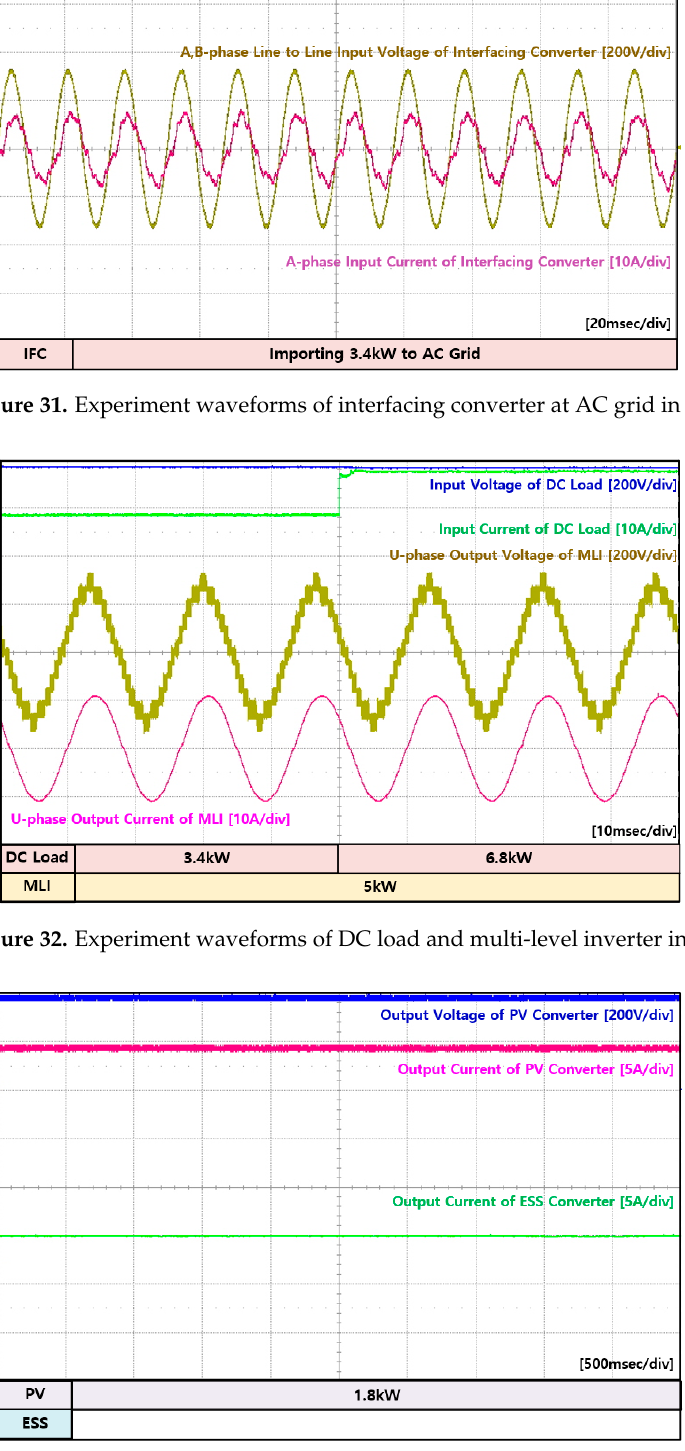
Figure 33. Experiment waveforms of PV converter and ESS converter in mode 6